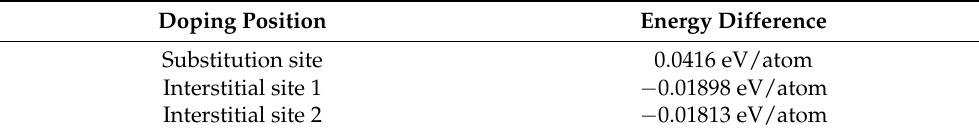
Figure 2. Position of Li + ions in Cs 2 SnI 6 lattice, ( a ) Li + replaced Cs + , ( b ) Li + interstitial site 1 and ( c ) Li + interstitial site 2. Table 1. Energy difference calculation results of Li + ions doped Cs 2 SnI 6 . Table 1. Energy difference calculation results of Li + ions doped Cs 2 SnI 6 .